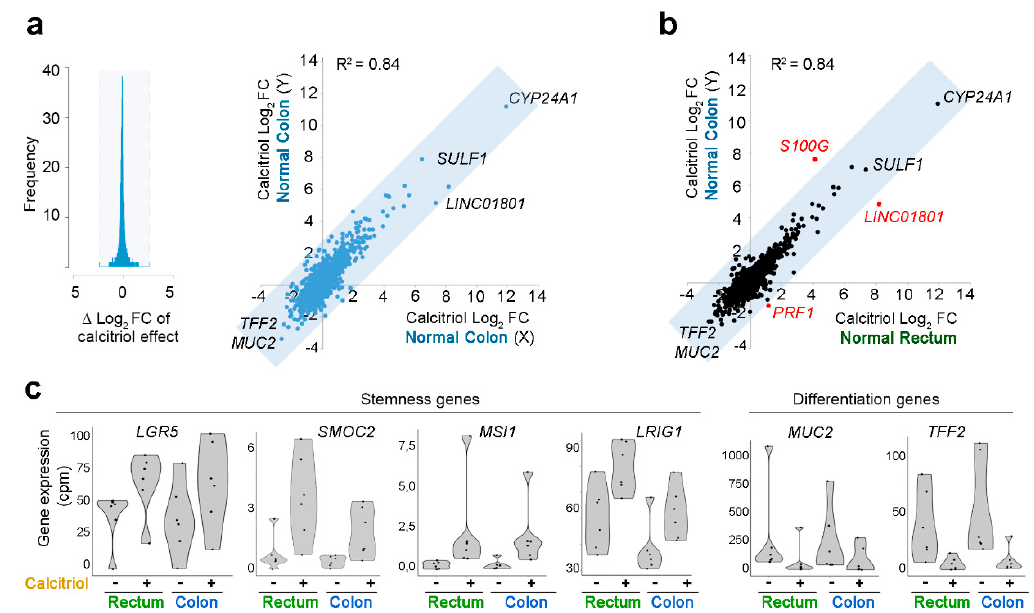
Figure 5. Gene expression profiles induced by calcitriol in normal-tissue organoids. ( a ) Comparison of the calcitriol response of normal colon organoids in independent RNA-seq studies under the same conditions (Normal Colon X: n = 6, GSE100785 [33]; Normal Colon Y: n = 6, present study; total n = 12). Gray shading shows the calculated “correlation zone” according to the dispersion of the Log 2 FC induced by calcitriol in the replicate studies. ( b ) Comparison of the calcitriol response of normal colon organoids and normal rectum organoids. Genes in black within the gray-shaded correlation zone are not considered di ff erentially regulated because the Log 2 FC di ff erence does not exceed that of the replicate assays presented in panel ( a ); genes in red outside of the correlation zone are considered di ff erentially regulated by calcitriol. ( c ) Violin plots showing the RNA expression (cpm = “counts per million”) of stemness and di ff erentiation genes in colon and rectum organoids and their regulation by calcitriol.